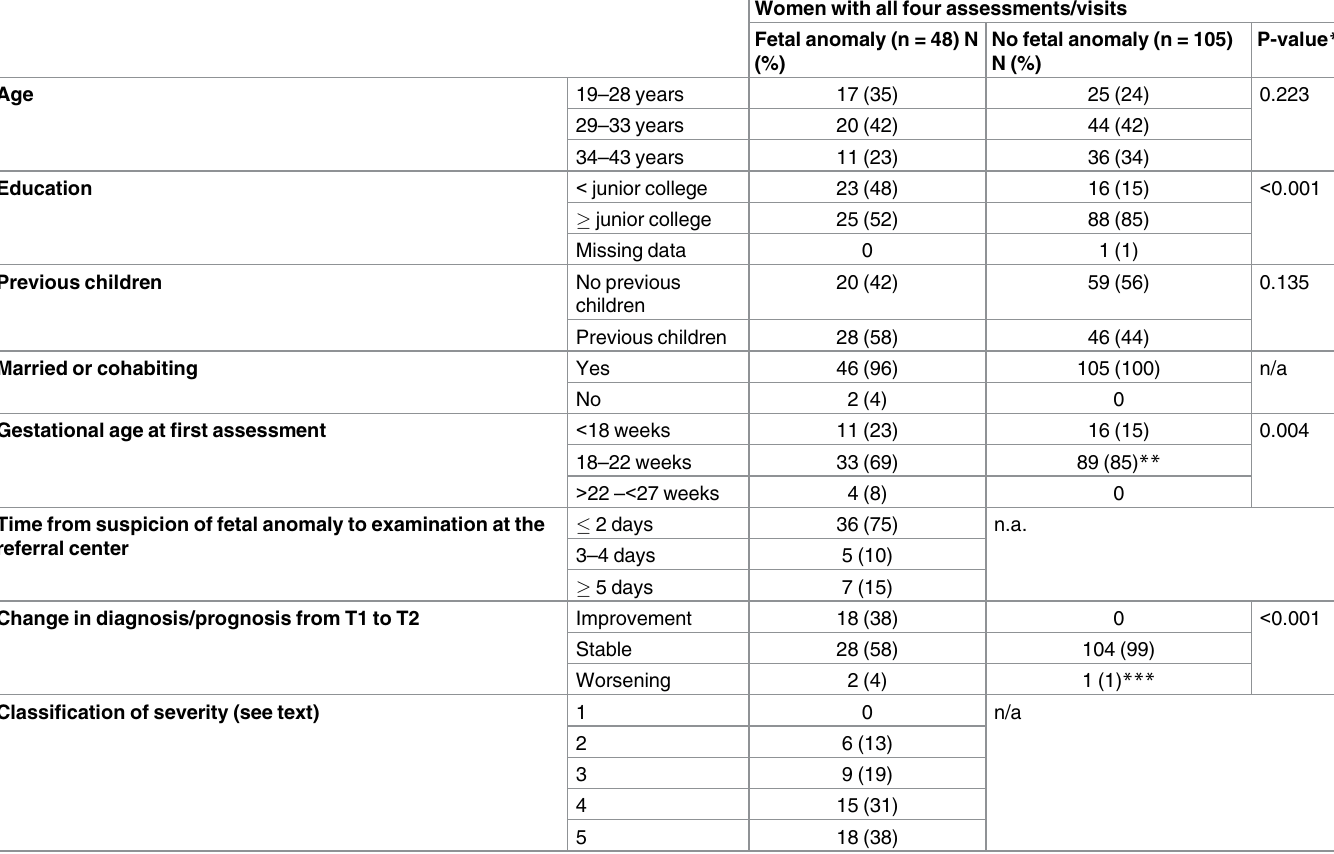
Table 1. Characteristics for women in group with and without fetal anomaly at inclusion